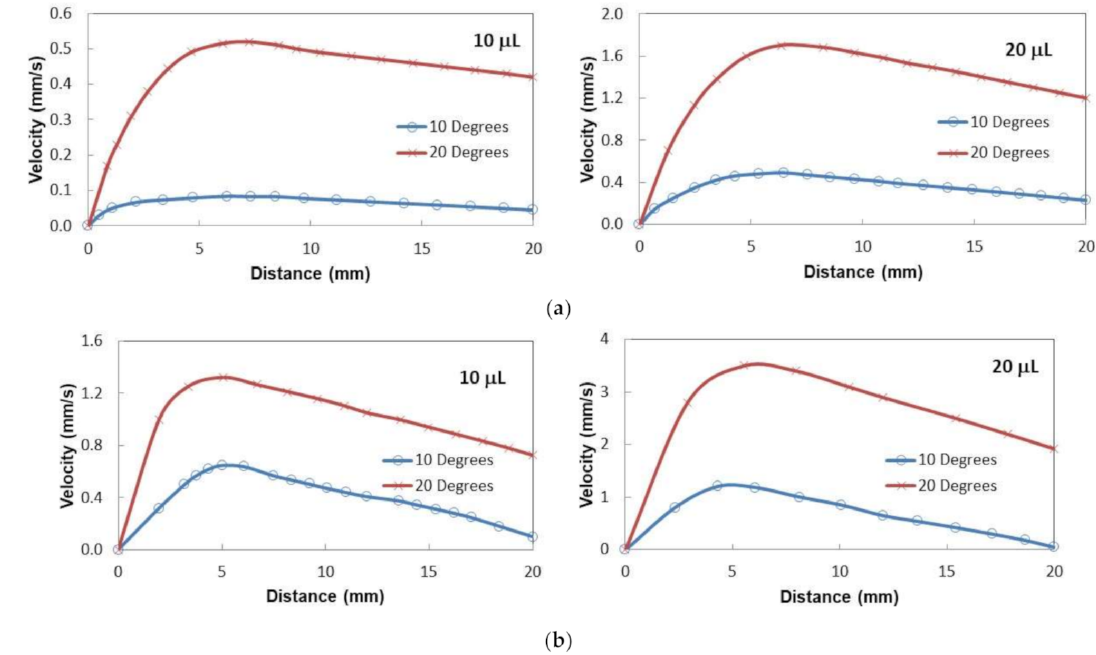
Figure 8. Droplet sliding velocity on inclined oil impregnated surface for two droplet volume and inclination angles. ( a ) Oil film thickness is 50 µ m. ( b ) Oil film thickness is 700 µ